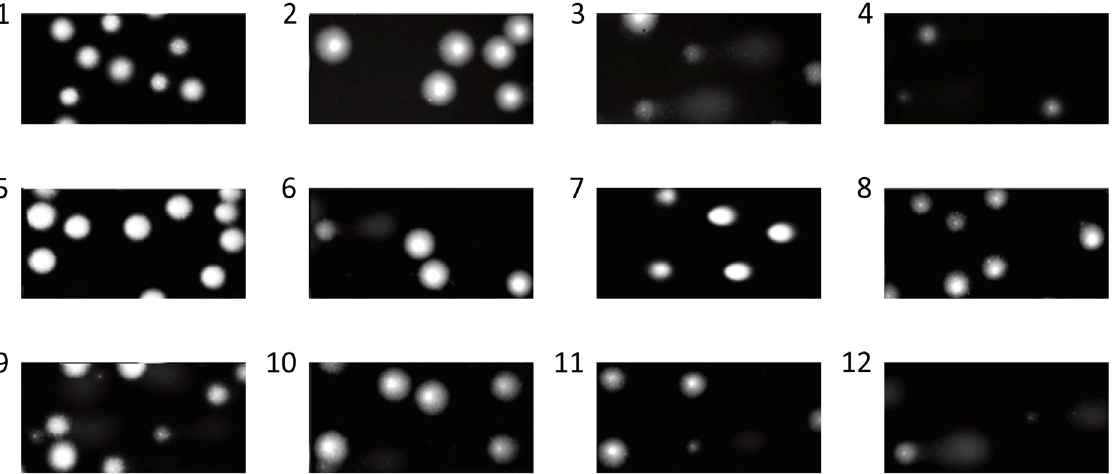
Figure 4. Representative photos of comets obtained in the alkaline version of the comet assay after pre-incubation of PBM cells for 2 h with extract and fractions (20%, 60% and 85%) at 50 µg/mL and incubation with 25 µM H 2 O 2 for 15 min on ice. 1. control ( − ); 2. DMSO; 3. control (+) (H 2 O 2 ); 4. control (+) with DMSO; 5. fraction 20%; 6. fraction 60%; 7. fraction 85%; 8. extract; 9. fraction 20% + H 2 O 2 ; 10. fraction 60% + H 2 O 2 ; 11. fraction 85% + H 2 O 2 ; 12. extract + H 2 O 2 .